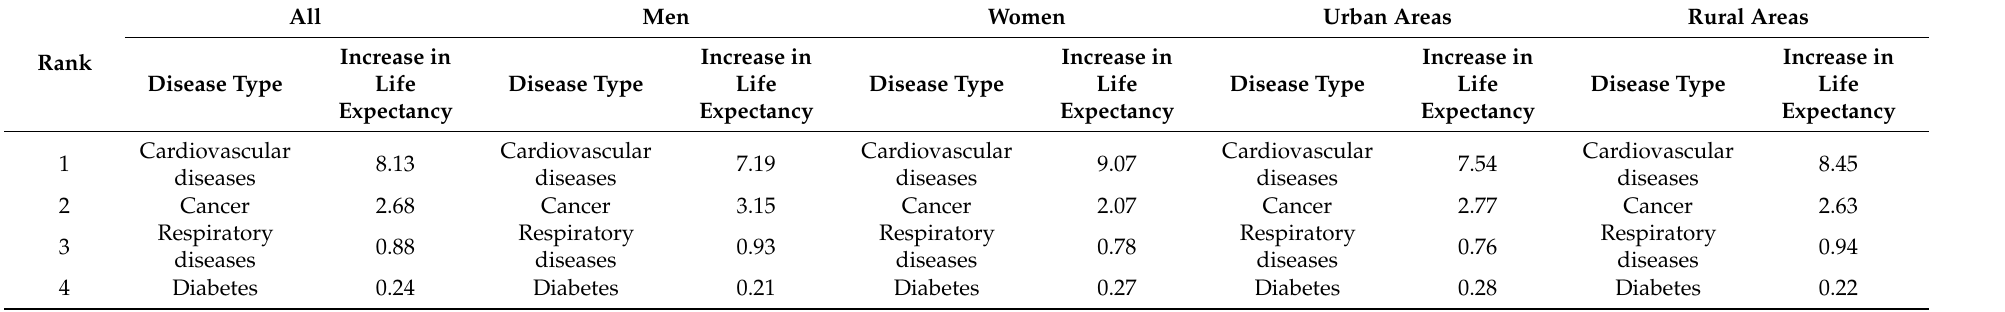
Table 2. Increases in life expectancy by gender and type of residential district after eliminating diseases’ deaths. China, 2019.